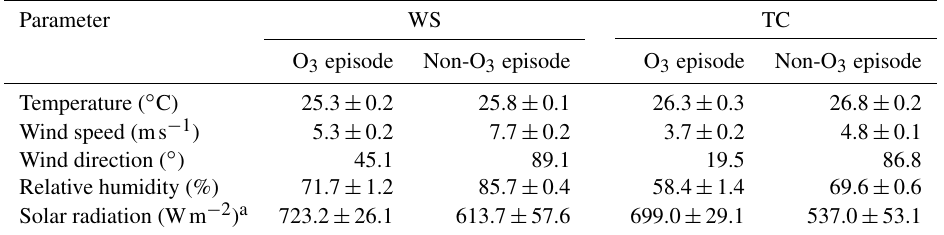
Table 2. Descriptive statistics (mean ± 95% C.I.) of meteorological parameters at the two sites during O 3 episodes and non-O 3 episodes days.